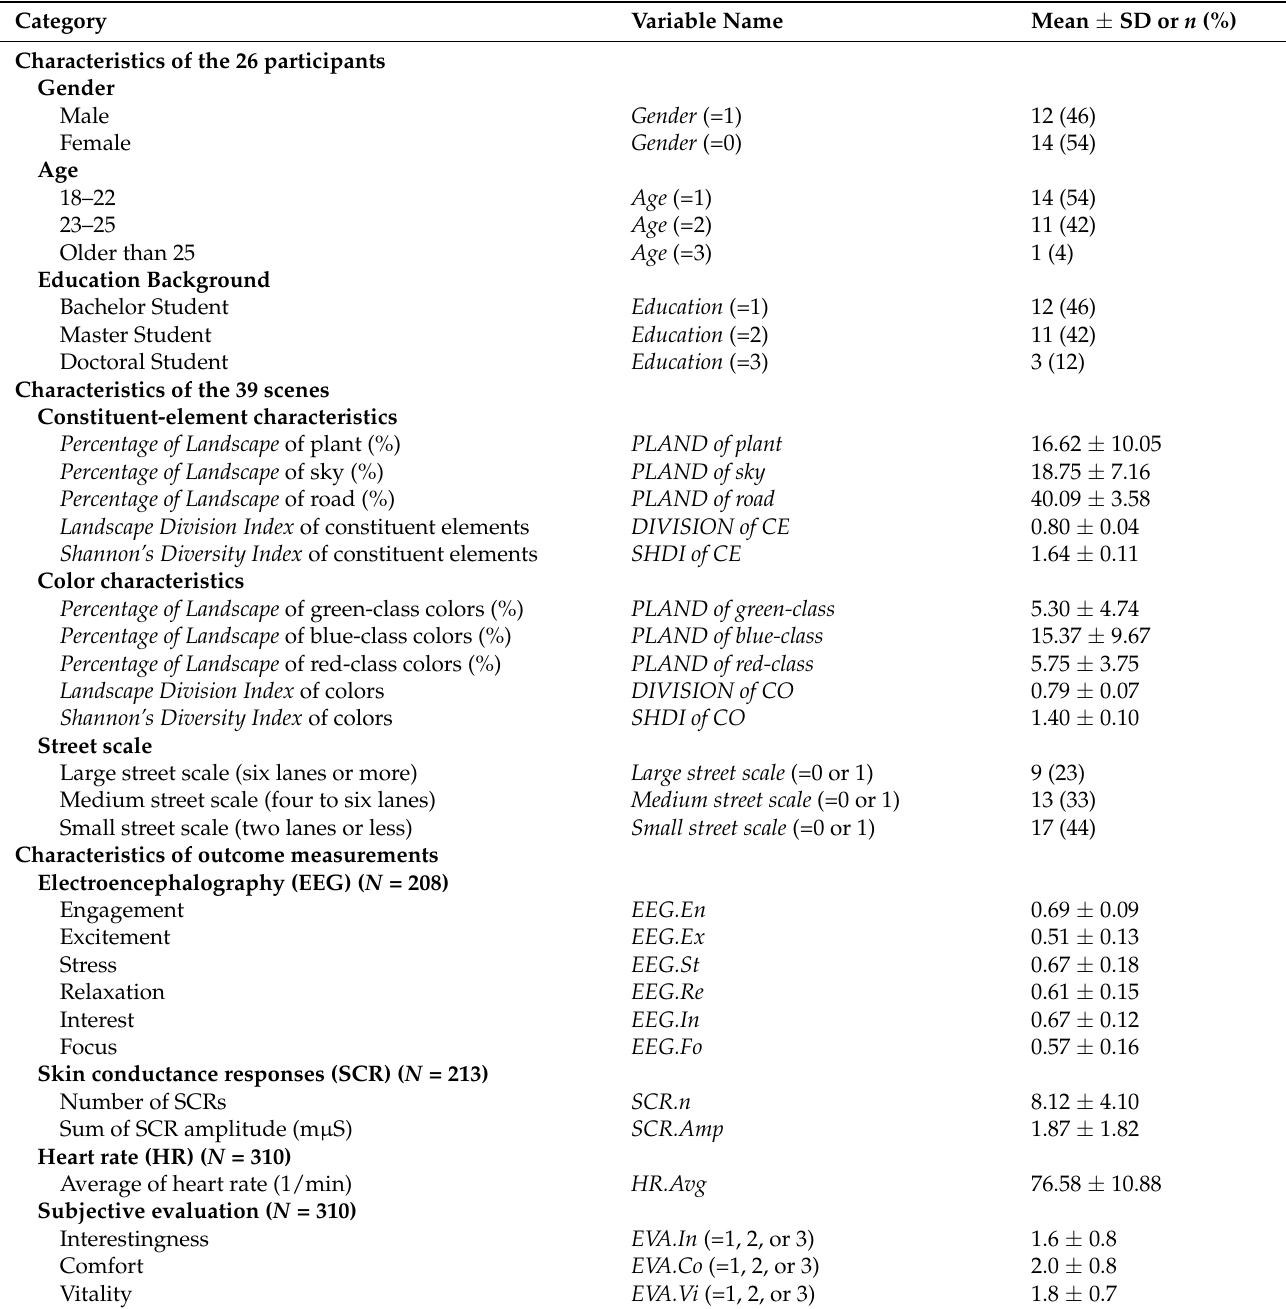
Table 3. Characteristics of the study population, scenes, and outcome